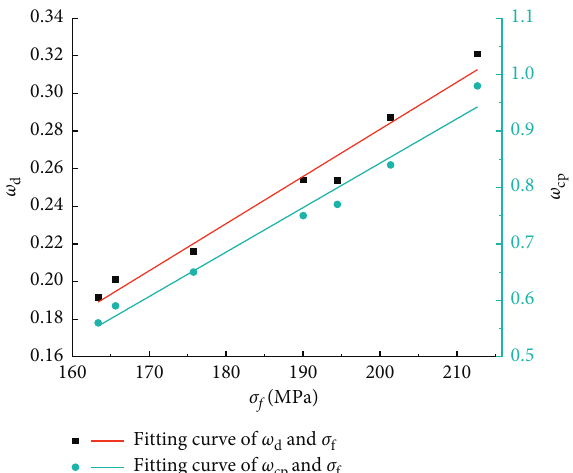
Figure 5: Relationship between the dynamic compressive strength of dolomite marble with ω d and ω cp